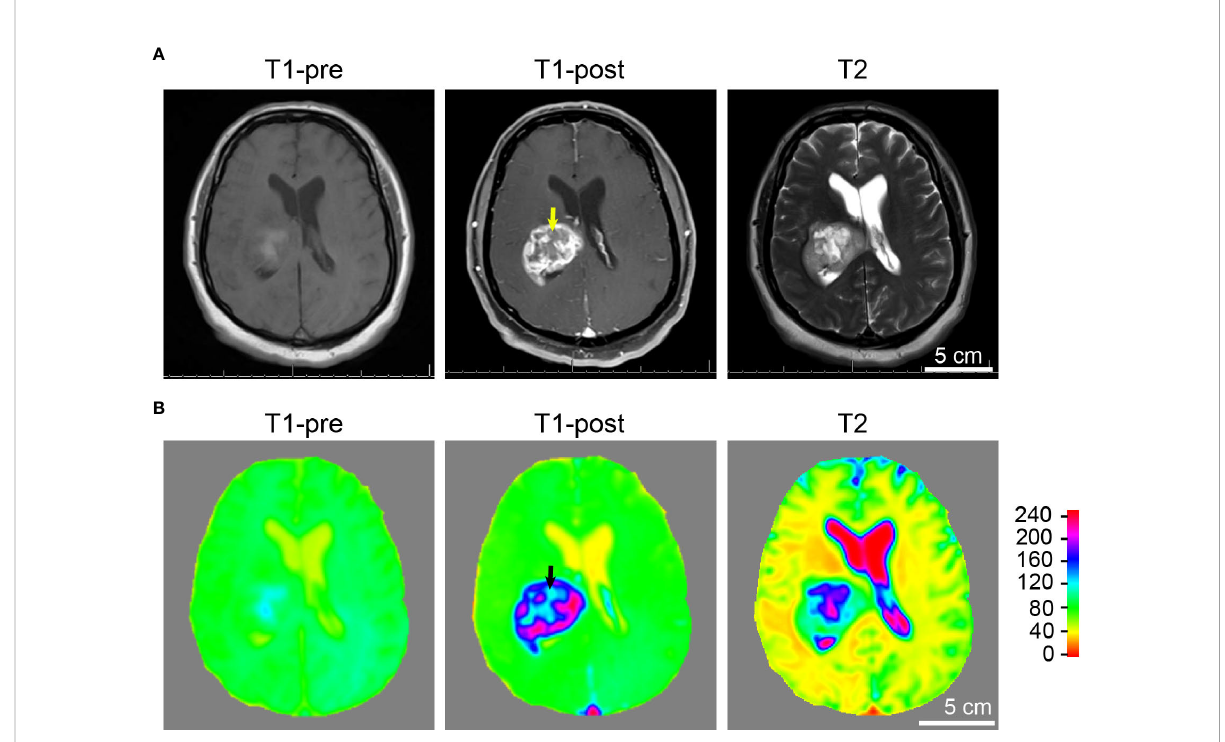
FIGURE 4 Tumor and necrosis visualized in a glioblastoma patient using standard MRI sequences. (A) A panel of representative images comparing T1 weighted pre-contrast (T1-pre), T1 weighted post-contrast (T1-post), and T2 sequences, which are routinely utilized in diagnostics and pre- operative planning for glioblastoma patient, are comparable to the images acquired using the murine GBM model which we devised. It is evident that T1-weighted post-gadolinium image remains by far the best sequence for the visualization of GBM tumor necrosis. (B) Heatmaps of signal intensities generated using MRI images as in panel (A) . Arrows: Less enhancing foci representing the central necrotic areas with irregular inner margins near the enhancing